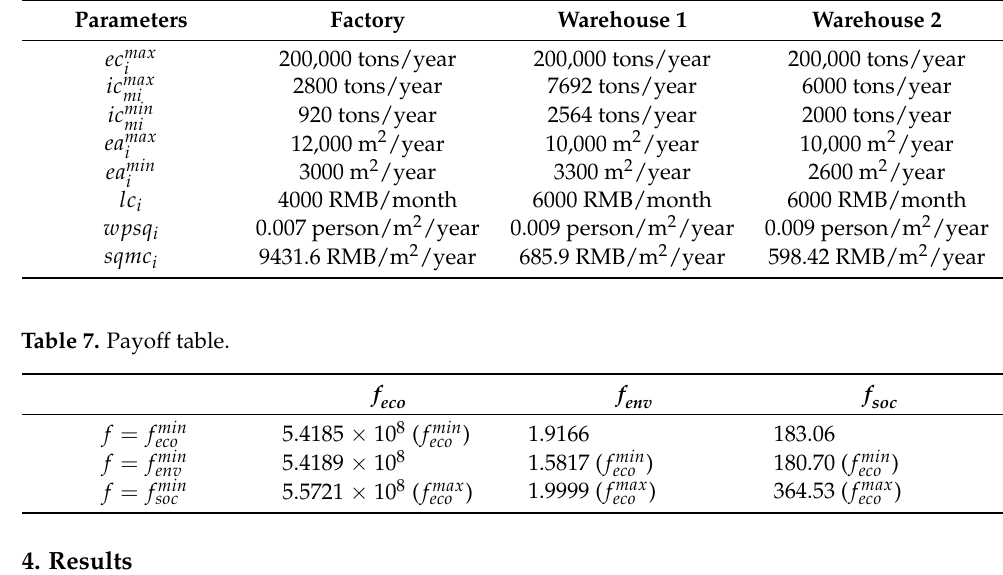
Table 6. Main parameters of factory and warehouses.